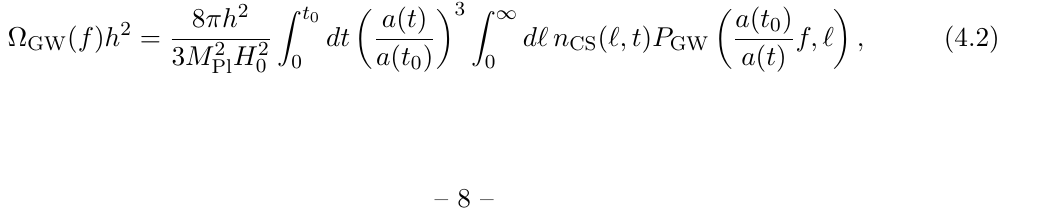
Figure 1 . Evolution of the ν R abundance for the four BPs in table 2. Y ν in blue and green curves, respectively. For comparison, we also show in orange curves the Y ν evolution without the zombie